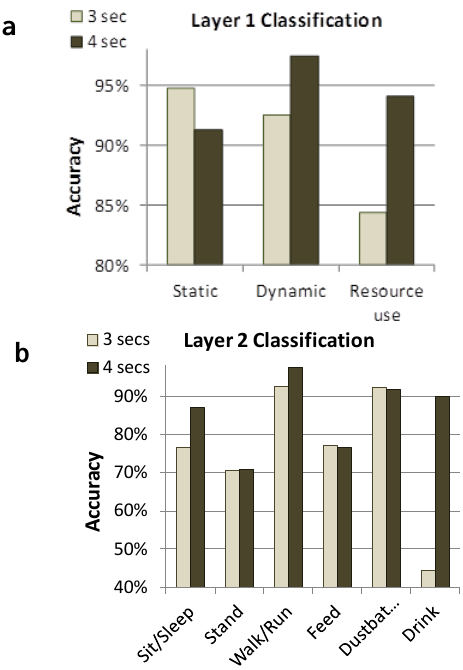
Figure 2. Layer 1 ( a ) and Layer 2 ( b ) classification systems to remotely identify performance of behaviors within 3 and 4 seconds windows [38]. Layer-1 accuracy was higher than Layer-2 accuracy, and in most cases, 4 s windows were more accurate than 3 s windows. Static behaviors (sit/sleep and stand) could accurately be distinguished from dynamic behaviors (walk and dust bathe) and both of these categories could be distinguished from resource use behaviors (feed and drink).